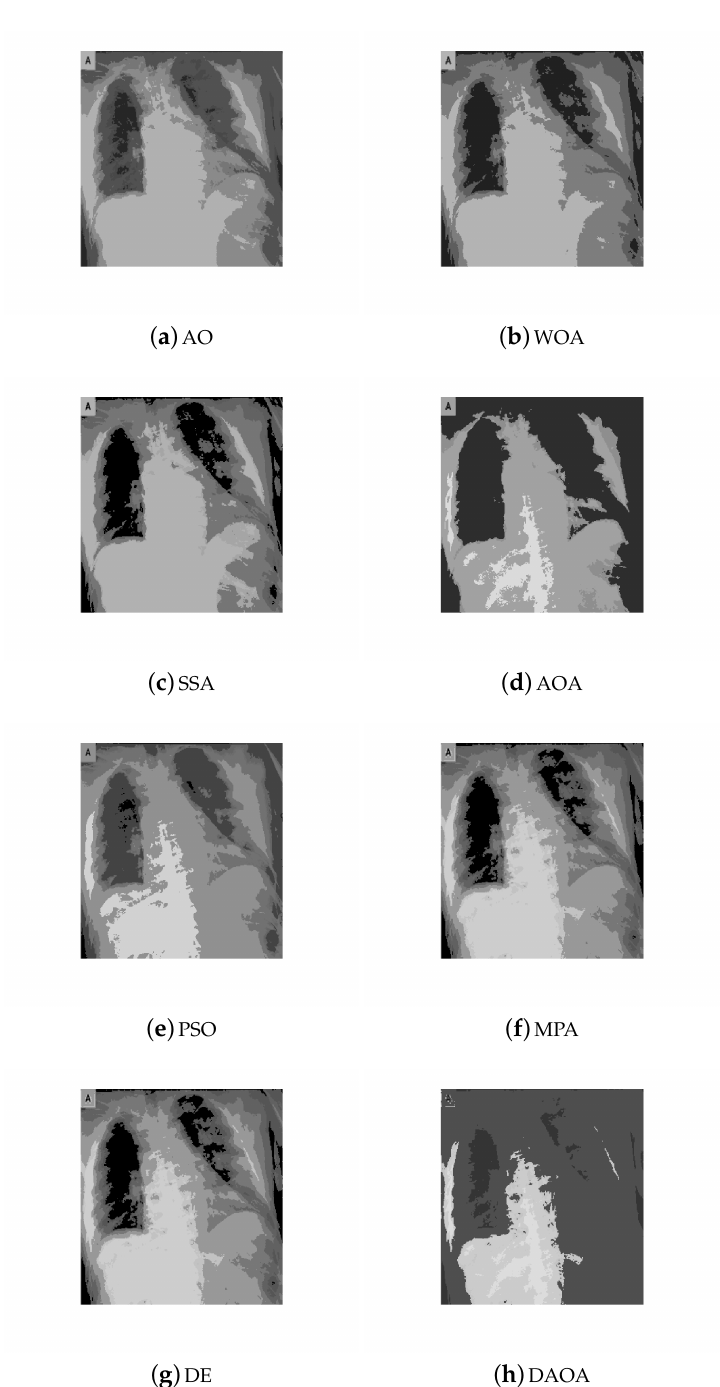
Figure 10. The segmented image (Test 8) by the comparative methods when the threshold value is